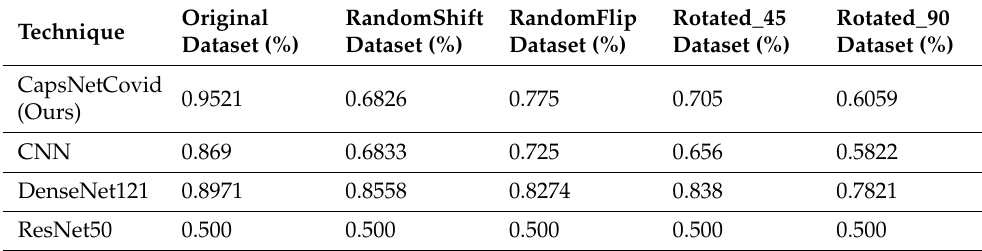
Table 15. AUC-ROC of CapsNetCovid, CNN, DenseNet121, and ResNet50 for multi-class classification.